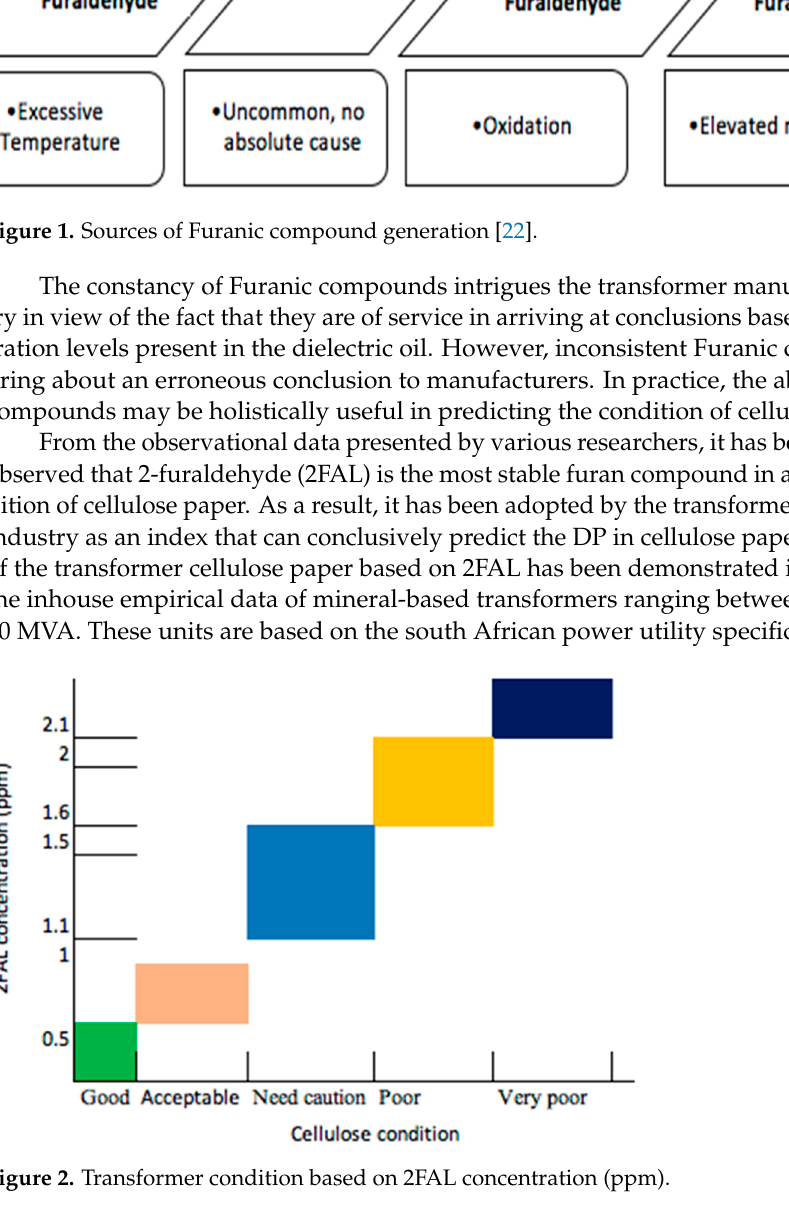
Figure 2. Transformer condition based on 2FAL concentration (ppm).